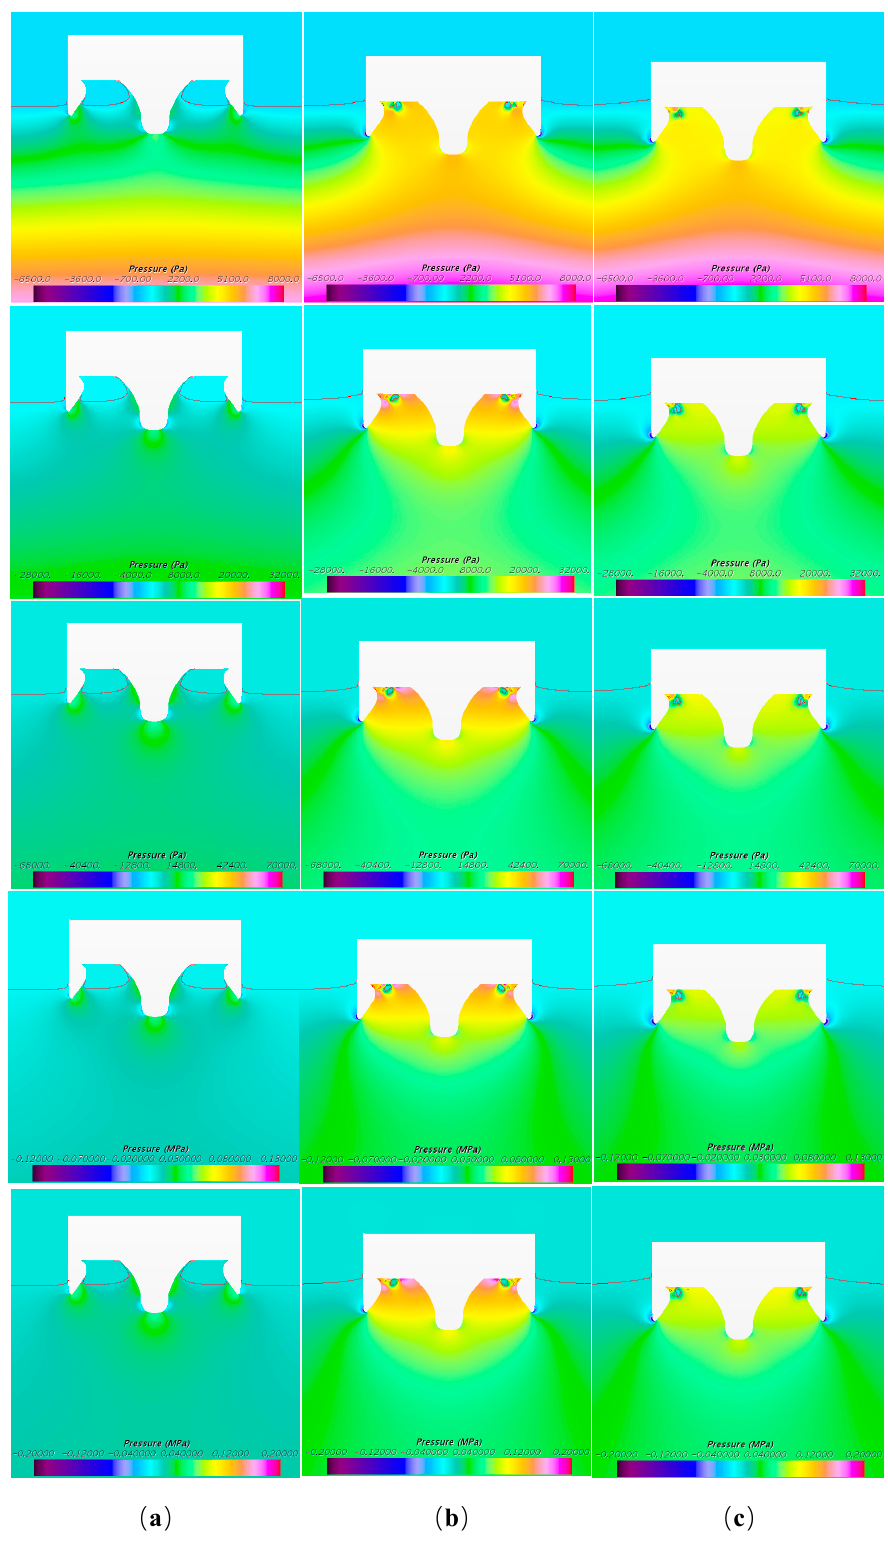
Figure 7. The pressure contours at the same penetration depth under different entry velocities; the red line is the free surface level (each row of pictures correspond to V, 2 V, 3 V, 4 V, and 5 V, respectively; columns ( a – c ) correspond to the penetration of 0.089 m, 0.155 m, and 0.178 m, respectively).